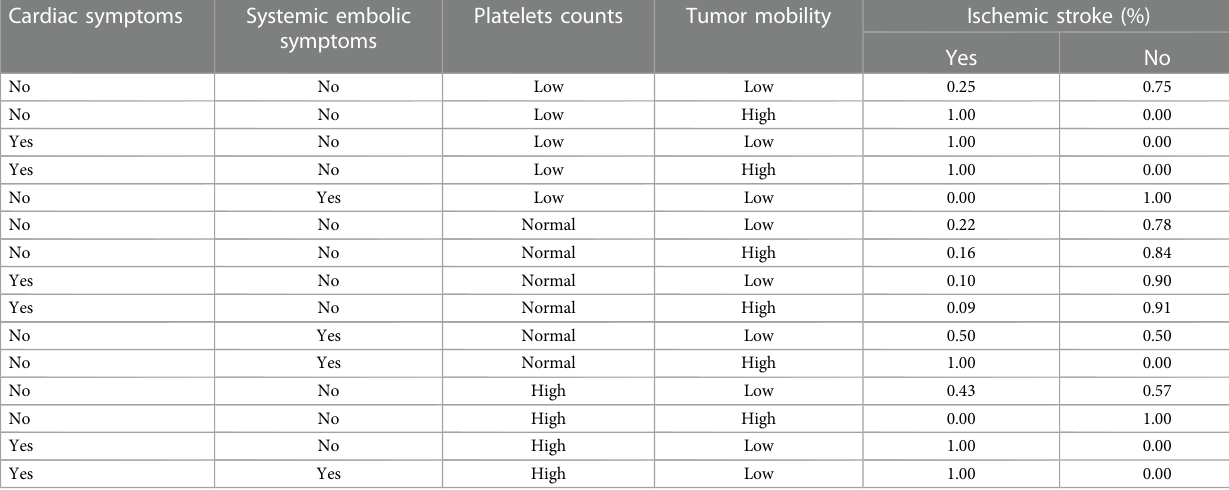
TABLE 3 The conditional probability distributions with tumors mobility, platelets counts, cardiac and systemic embolic symptoms as parent nodes. Cardiac symptoms Systemic embolic